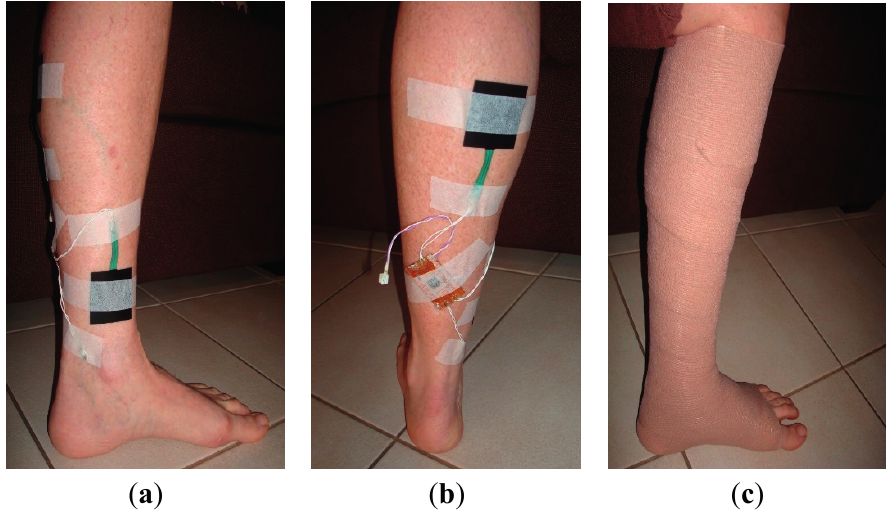
Figure 10. Experiments on a healthy human volunteer; ( a ) placement of one pressure sensor at above the ankle; ( b ) placement of the second pressure sensor at calf level. The telemetric sensing system was also attached on the limb with tape; ( c ) pressure sensors and the telemetry device hidden under the